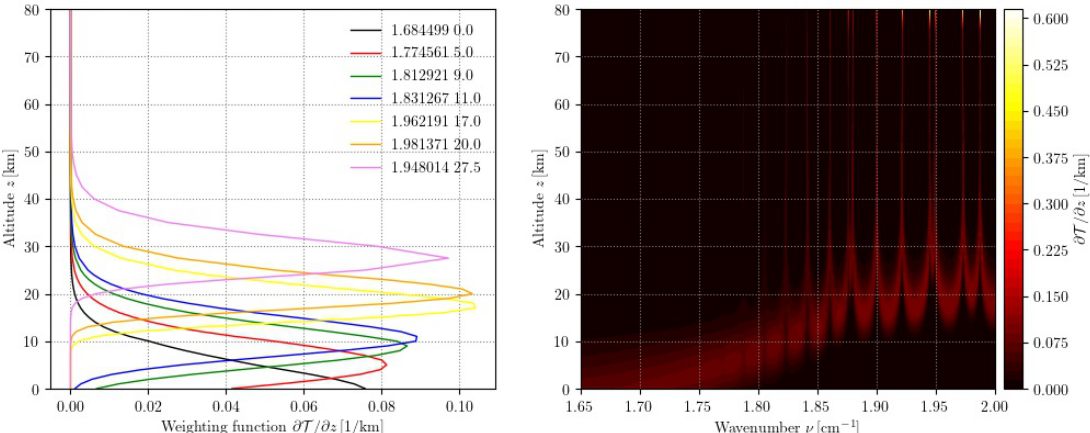
Figure 6. Combination of wfPlot. The labels in the left plot correspond to the central wavenumbers (in cm − 1 ) for each of the seven SSM/T channels shown in Fig. 7.13 of Liou [2]. The second number indicates the altitude grid point (in km) next to the maximum. This example has been generated with sas = atmRead(’/data/atmos/50/subarcticSummer.xy’, zToA=80)